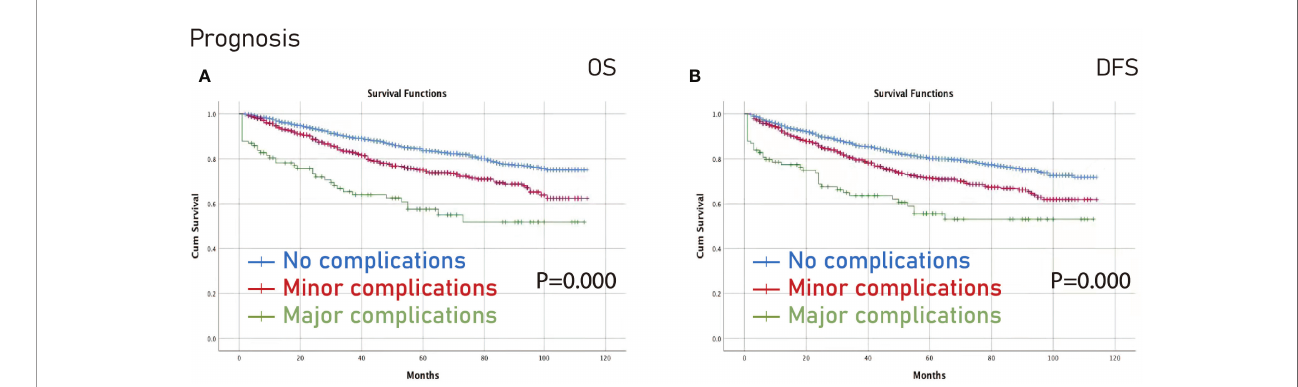
FIGURE 2 | Prognosis among different complications groups. (A) , OS; (B) , DFS. OS, overall survival; DFS, disease-free survival.